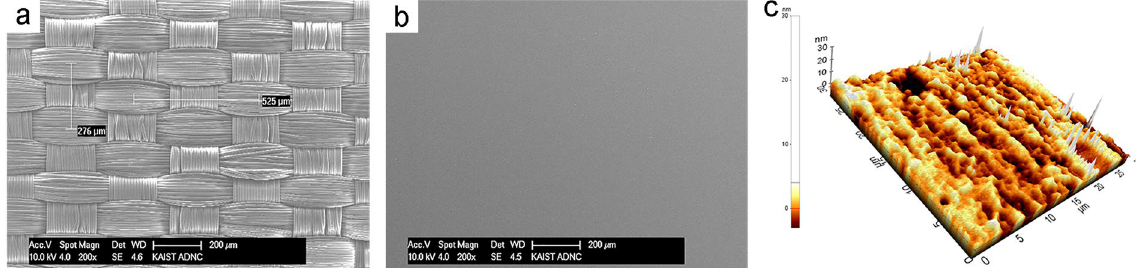
Figure 1. Scanning electron microscope (SEM) and atomic force microscope (AFM) images of the fabric before and after the lamination process: ( a,b ) SEM image of the fabric surface ( a ) before planarization, and ( b ) after planarization. ( c ) Three-dimensional AFM image of the fabric surface after